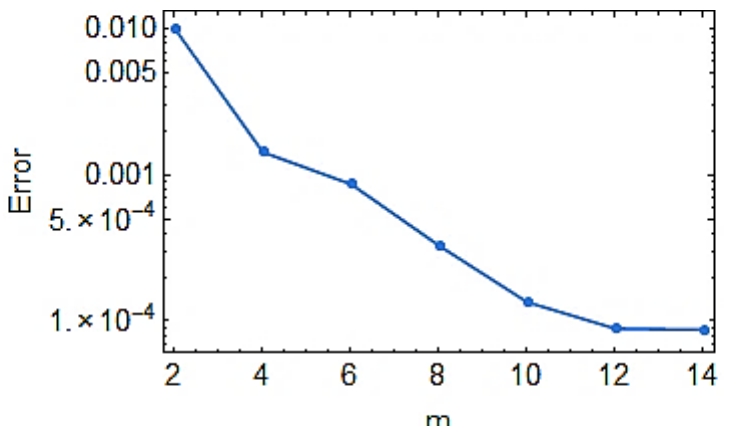
Figure 20. Error of the fluid flow problem at 15th order of HAM when β = 0.5, M = 0.2, Da = 0.5, Rd = 0.3,Pr = 1.0, Ec = 0.1, S = 0.1, Nb = 2.0, Nt = 0.5, Le = 1.0, and λ = 0.5. Table 1. Comparison of the current analysis with previous studies.